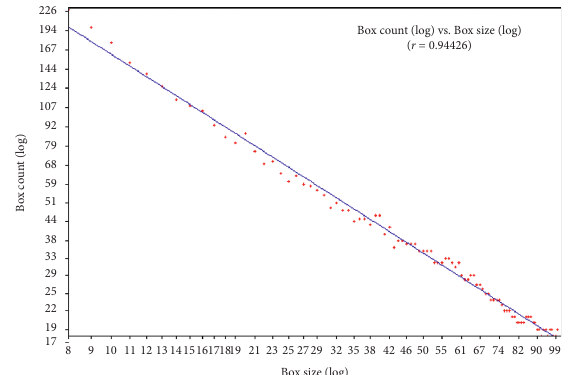
Figure 6: Fractal dimension curve calculated by the box dimension method for surface cracks of the failed